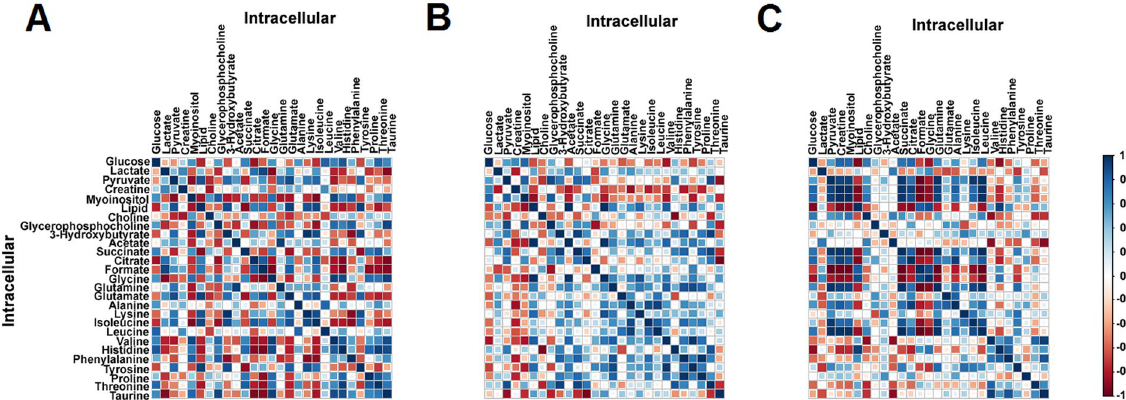
Figure 5. Differential correlation heatmap of intracellular metabolites using Pearson’s method. Metabolite- metabolite correlation of hESC ( A–C ) in ND, DEC and DEC + HSP65 is shown. Blue squares indicate significant positive correlations, white squares show non-significant correlations and red squares indicate significant negative correlations. Intermediate correlation coefficient values are indicated by size of the squares and varying shades of blue and red color.